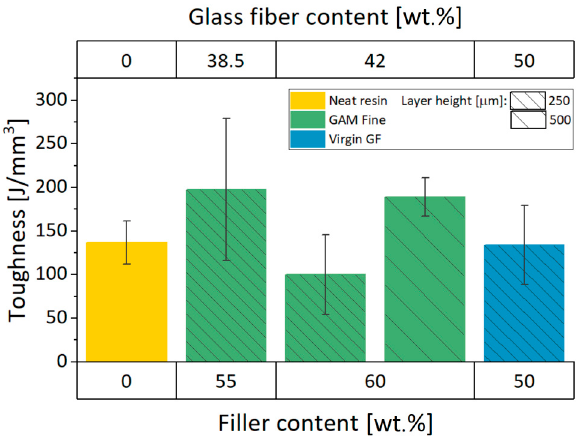
Figure 9. Toughness values for Neat Resin, FIL 100, and GAM Fine-reinforced resins.